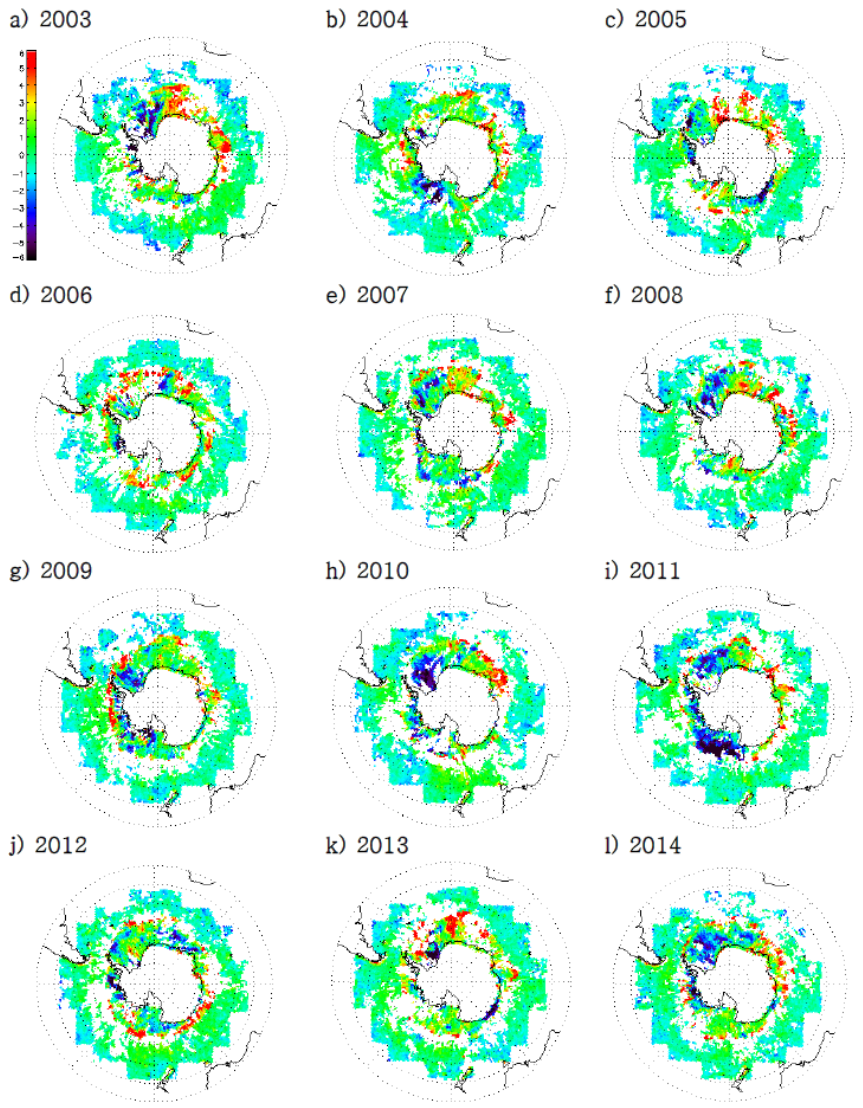
Figure 5. Annual-average spatial distributions of the T skin (MODIS) minus T skin (AA_V6) over the Southern Hemisphere during 15– 23